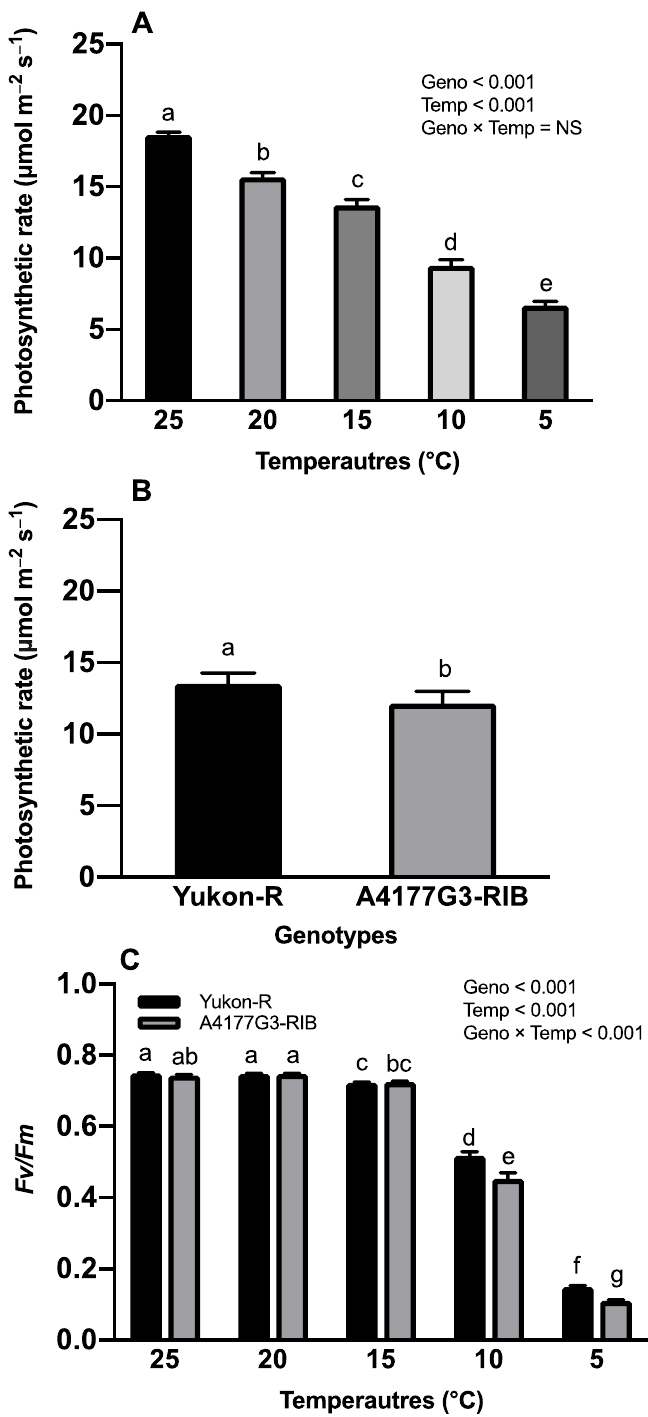
Figure 3. Effects of temperature regime on photosynthesis rate of silage corn ( A ). Comparative photosynthesis rate of silage corn genotypes ( B ) . Interactive effects of temperature and silage corn genotypes on photochemical efficiency of PS-II ( F v / F m ) ( C ). Each vertical bar represents the average of replicates ± SE of the mean ( n = 30 for Geno, n = 12 for Temp, n = 6 for Geno × Temp). Different lowercase letters indicate significant differences among treatments at p ≤ 0.05 according to Fisher’s Least Significant test. Geno = genotype; Temp = temperature.